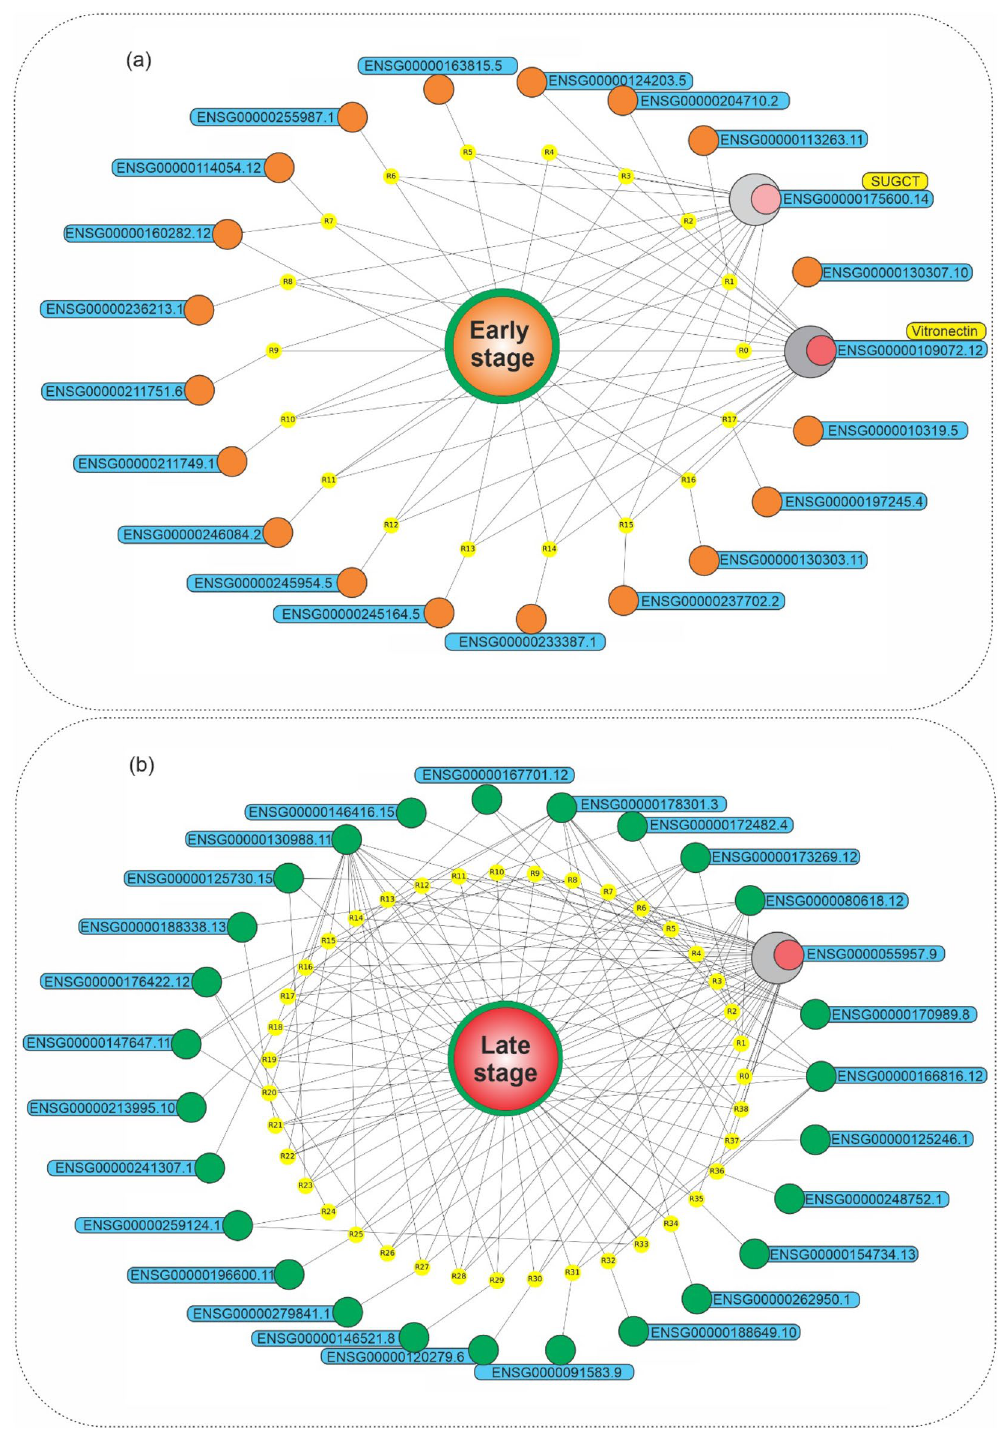
Figure 4. Graph network of mRNAs at early- and late-stages of HCC. Graph network of ( a ) early-stage related association rules (with lift > 1.21) and ( b ) late-stage related association rules (with lift > 1.38), in which the early- stage phenotype, its rules, and related mRNAs were presented, by orange, yellow, and blue colors, respectively. Python programming language (version 3.9) and Matplotlib library (version 3.6.0) were used to draw the plots, all of them are open